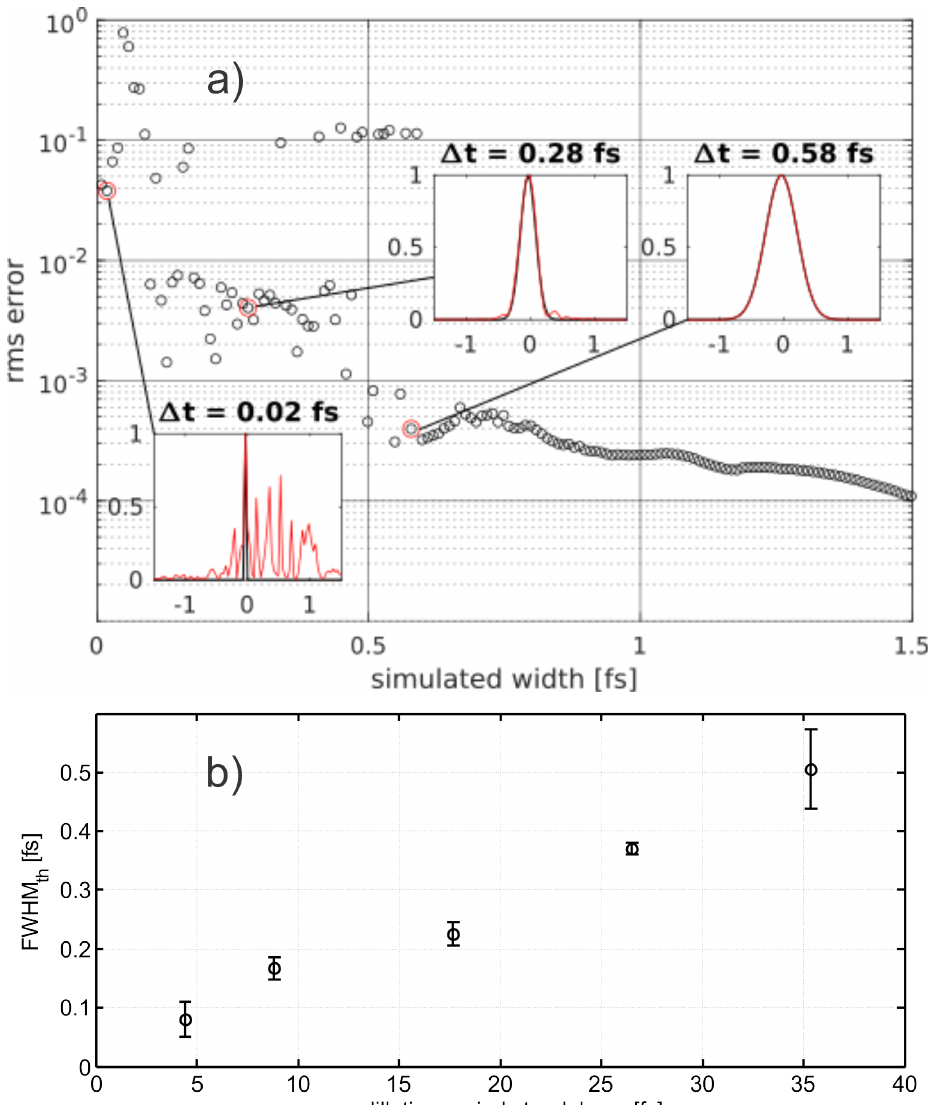
Figure 1. ( a ) Rms error versus pulse duration of a Gauss-shaped X-ray pulse. The insets show the original (black curve) and the reconstructed (red curve) X-ray pulses for three different pulse durations, i.e., 0.02 fs, 0.28 fs and 0.58 fs. ( b ) Shortest reliably reconstructed pulse duration versus the streak field oscillation